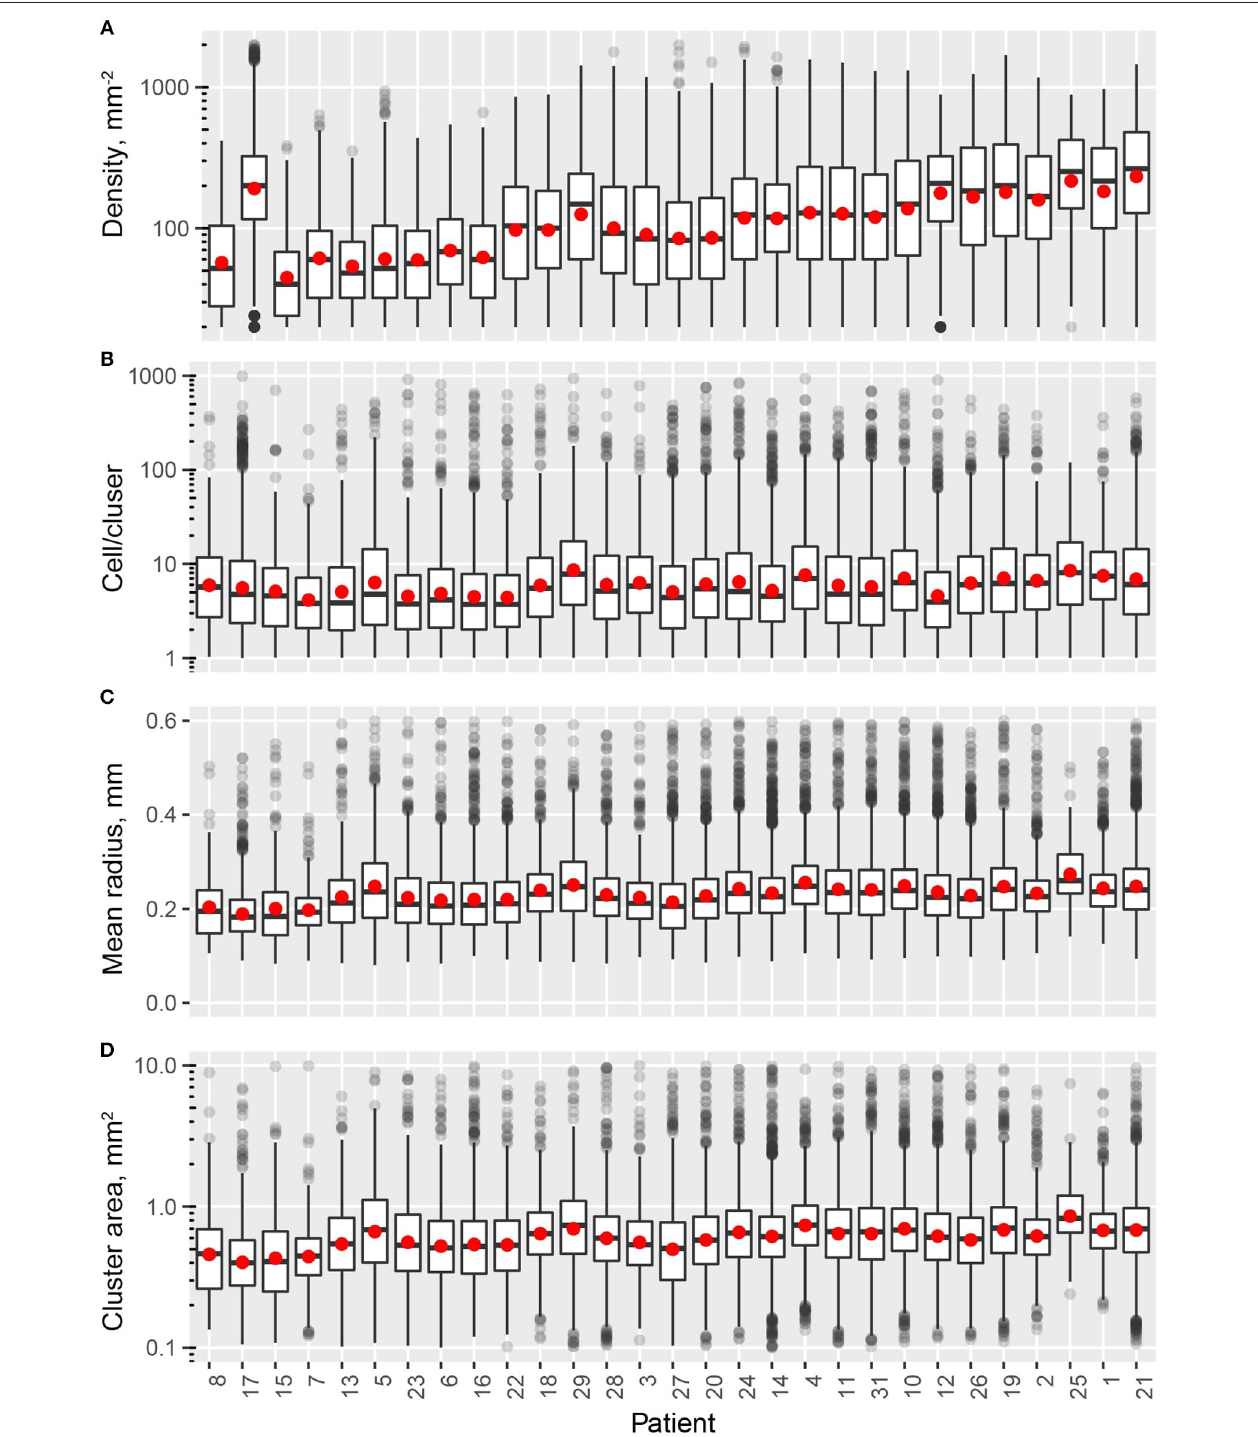
FIGURE 4 | Intra- and inter-tumor heterogeneity quantification using spatial statistics. Patients are sorted by overall CD8 lower hinges indicate 25th and 75th percentiles, respectively. Red dot indicate the mean value. (A) Cell density within each window. (B) Cell/cluster is fitted parameter from modified Thomas process model. (C) Mean distance is the average distance from each point to cluster center. (D) Cluster area is calculated at 95% level of the bivariate normal distribution.